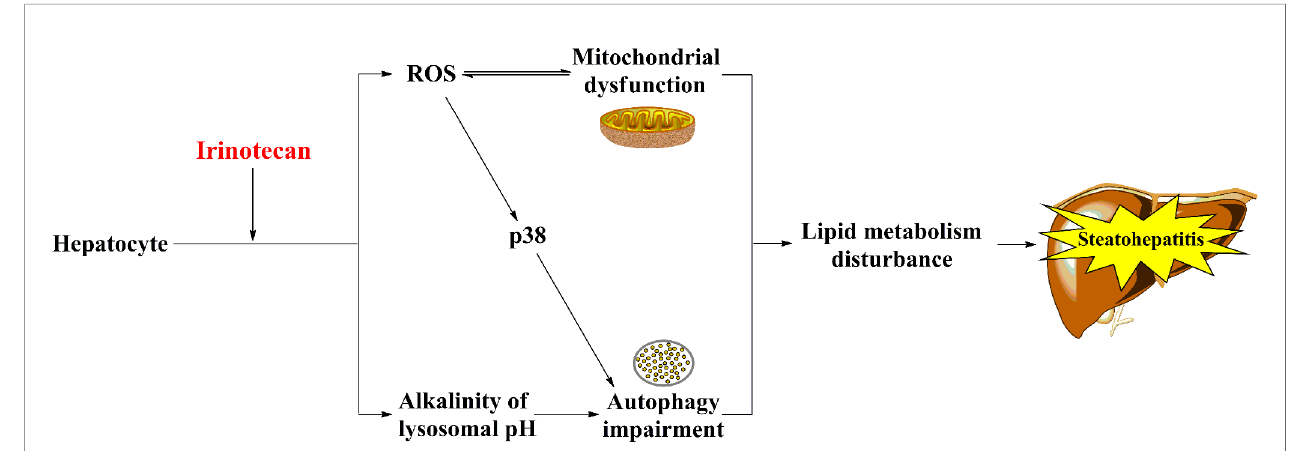
FIGURE 2 | The potential mechanisms of IIS. Irinotecan-caused mitochondrial dysfunction and autophagy impairment result in lipid metabolism disturbance ultimately, which may involve in the pathogenesis of